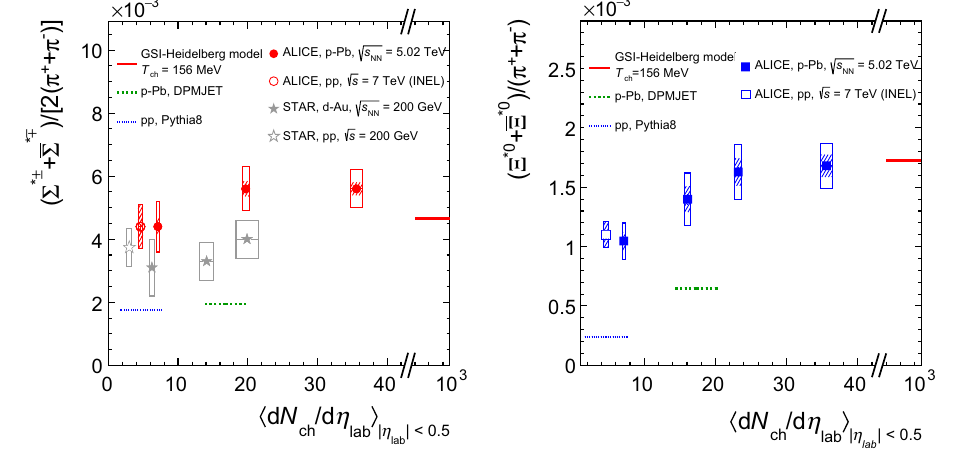
Fig. 9 ( Left ) ratio of (cid:3) ∗± to π ± and ( Right ) ratio of (cid:4) ∗ 0 to π ± , mea- sured in pp [17,32,41,42], d–Au [32,37] and p–Pb [24] collisions, as a function of the average charged particle density ( (cid:3) d N ch /d η lab (cid:4) ) mea- sured at midrapidity. Statistical uncertainties ( bars ) are shown as well